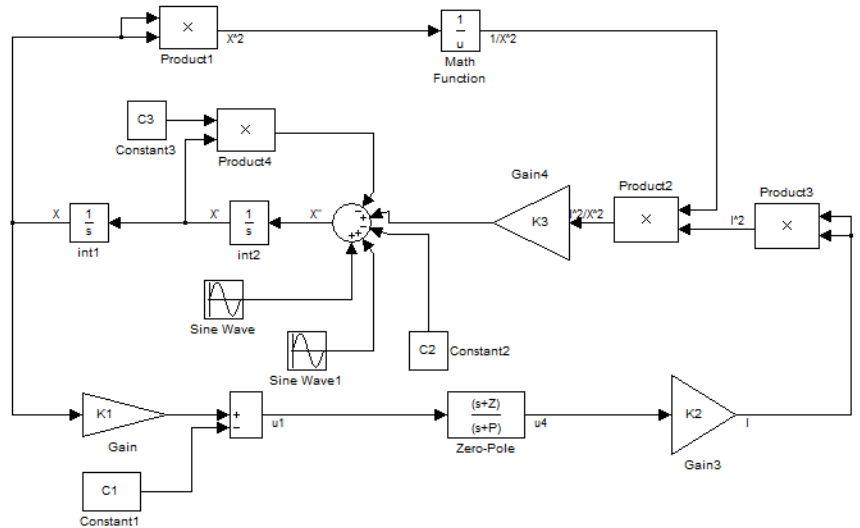
Figure 4. Motion simulation model of the repulsive electromagnetic suspension